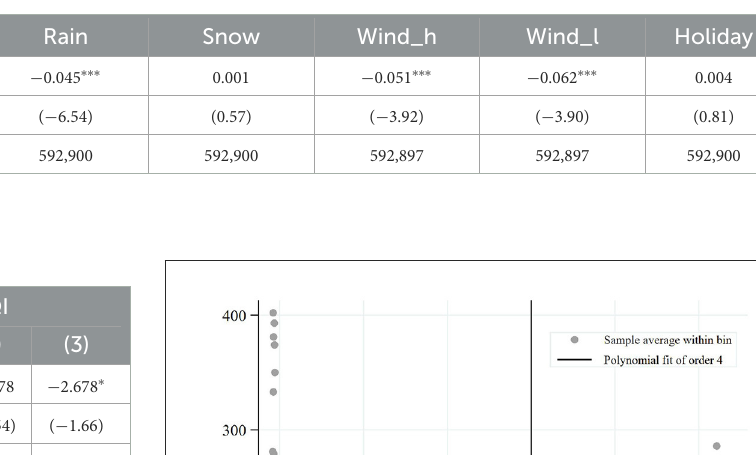
TABLE 3 Covariate continuity test.